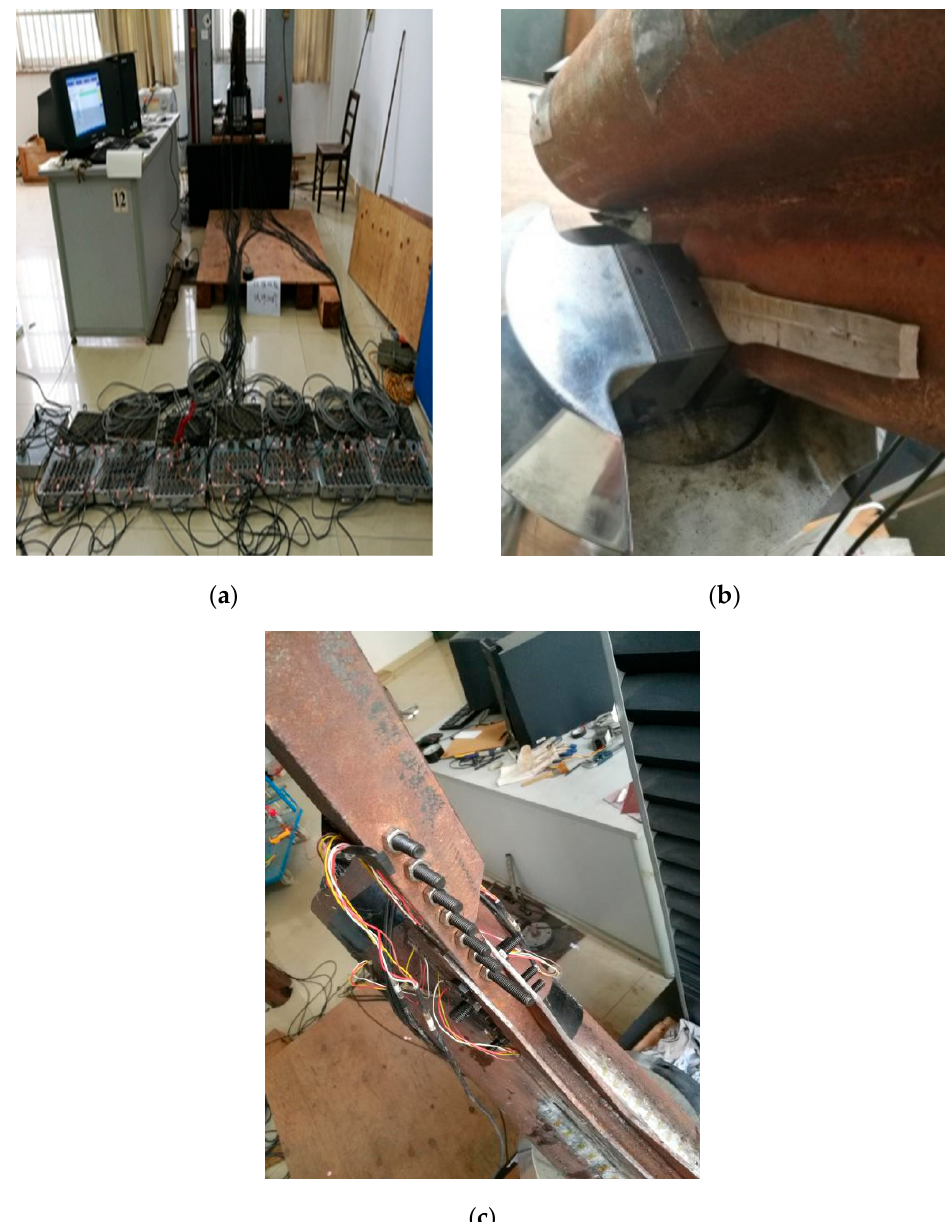
Figure 12. ( a ) Test loading device and strain acquisition system; ( b ) PSLSPJ installed on testing machine; ( c ) PDLDPJ installed on testing machine.